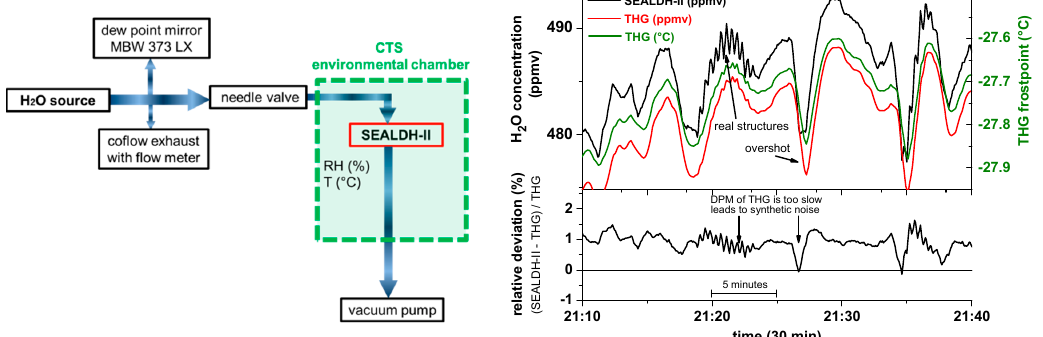
Figure 9. Left : Setup for validation of SEALDH-II’s response to a variation in ambient temperature and humidity; Right: Detailed view on the results. The traceable humidity generator (THG) has a highly defined absolute accuracy but within the uncertainty an undefined short-term behavior. The precision of SEALDH-II is high enough to resolve these structures, while the THG’s internal dew point mirror hygrometer (DPM) is too slow to resolve them. This yields to synthetic noise in the relative deviation between SEALDH-II and THG.